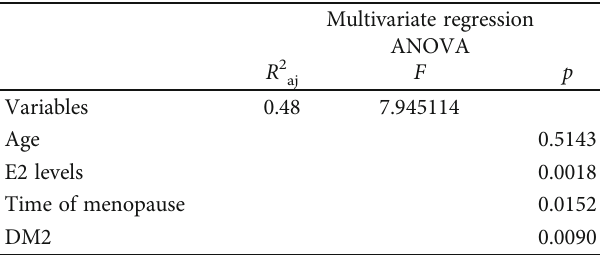
Table 2: Multivariate regression analysis between eHSP72, age, E2 levels, time of menopause, and DM2 in postmenopausal